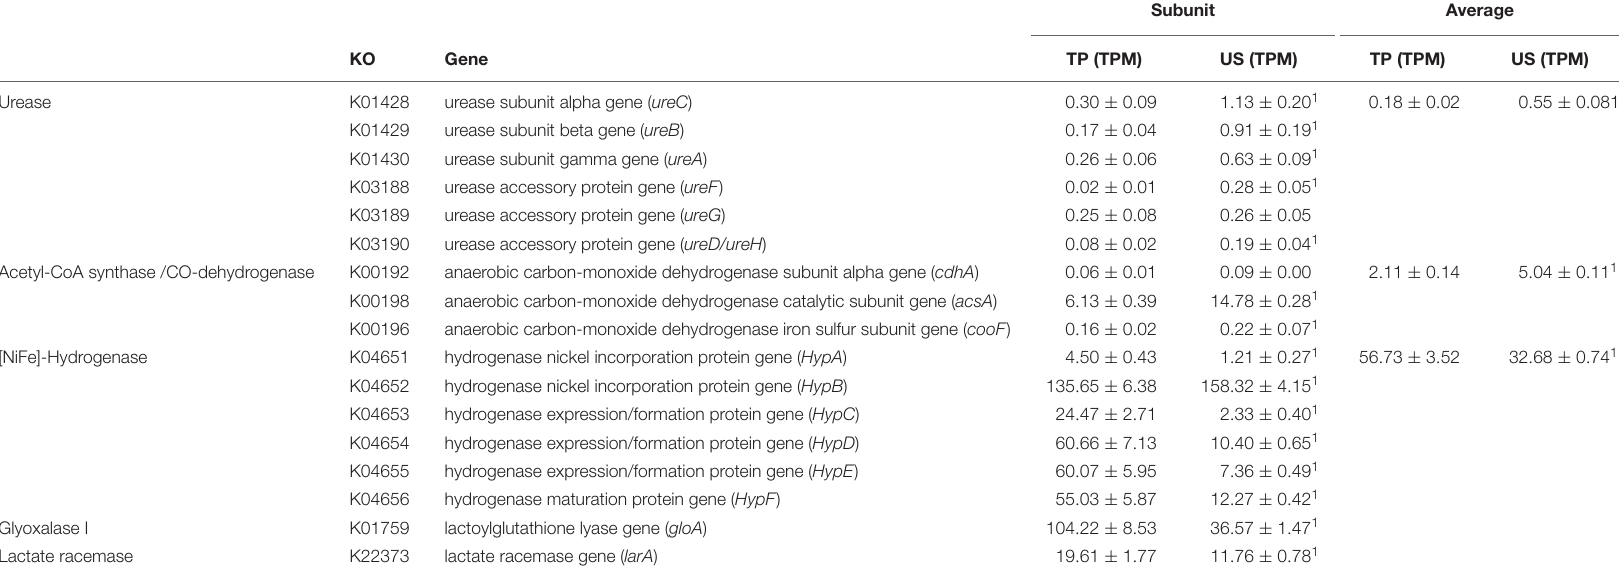
Values are mean ± standard error (SE). 1 FDR <